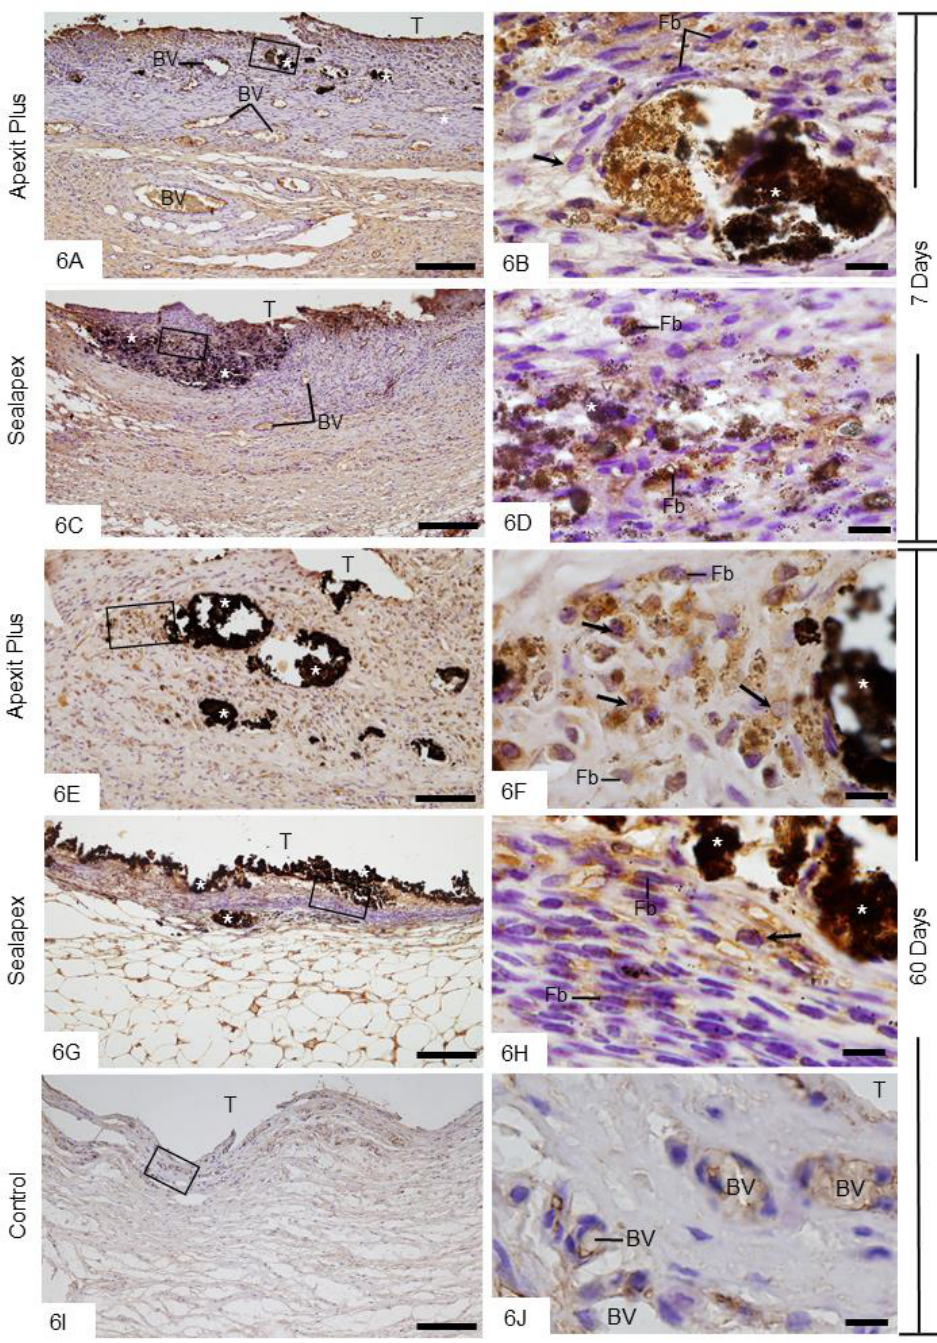
Figure 6. Photomicrographs show sections submitted to the von Kossa method (black) followed by immunohistochemistry for detection of ALP (brown-yellow) and counterstained with hematoxylin. A , C , E , G General view of the capsules showing von Kossa-positive structures (asterisks). Note that ALP-immunolabelled cells are located mainly next to the von Kossa-positive structures (asterisks) and in the internal surface of capsules. B , D , F , H Higher magnifications showing outlined area of the general view. Fibroblasts (Fb) and round / ovoid cells (arrows) show strongly ALP-immunolabelled cytoplasm (brown-yellow). I , J None or weak ALP immunolabelling is present in the capsule of control group. In Figure 6J, outlined area of Figure 6I, some vascular cells exhibit subtle ALP immunoreactivity. T, space of the implanted tube; BV, blood vessel profiles. Bars: 150 µ m ( A , C , E , G , I ) and 10 µ m ( B , D , F , H , J